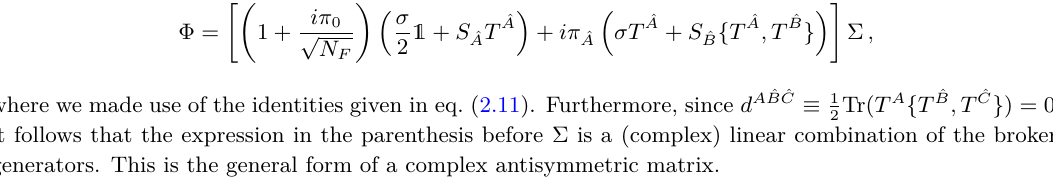
) for g = 5 , r = 10 − 10 , r = 8 , normalized 5 1 2 2